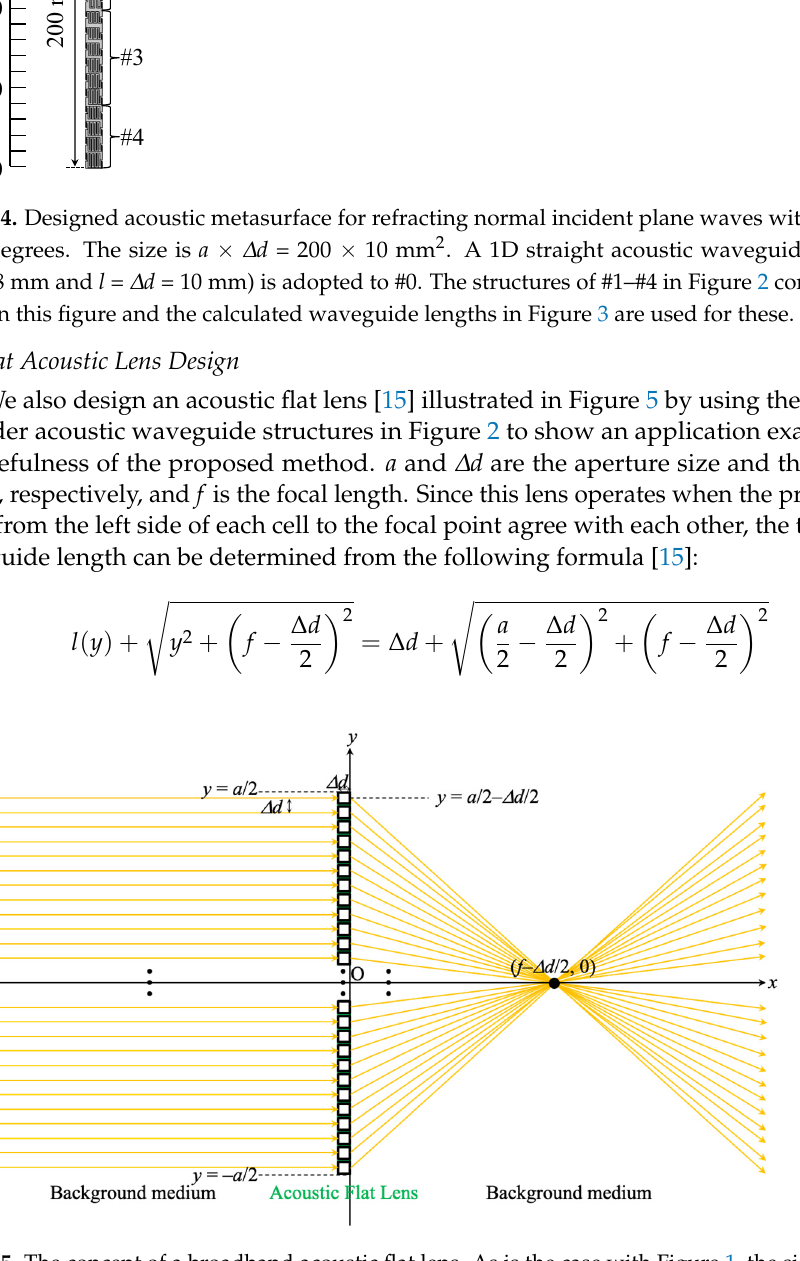
Figure 5. The concept of a broadband acoustic flat lens. As is the case with Figure 1, the size is a × ∆ d and the 1D TL model and the 2D TL model are used for the acoustic metasurface and the background medium. The position of ( x , y ) = ( f − ∆ d /2, 0) corresponds to the focal point of the lens.